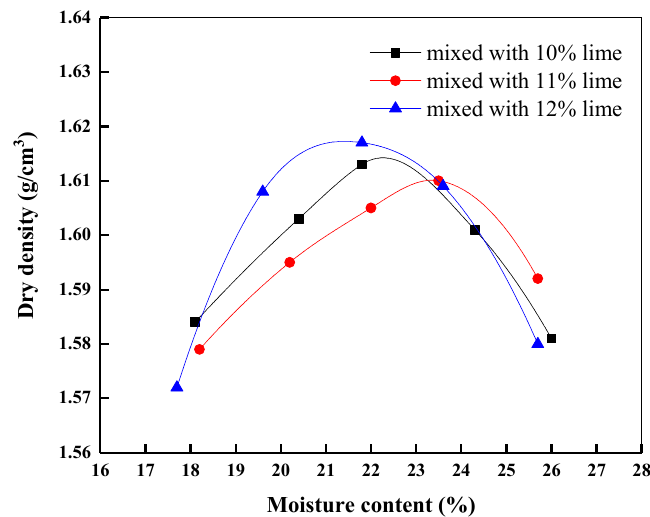
Figure 7. Compaction curve of lime-solidified manganese slag.